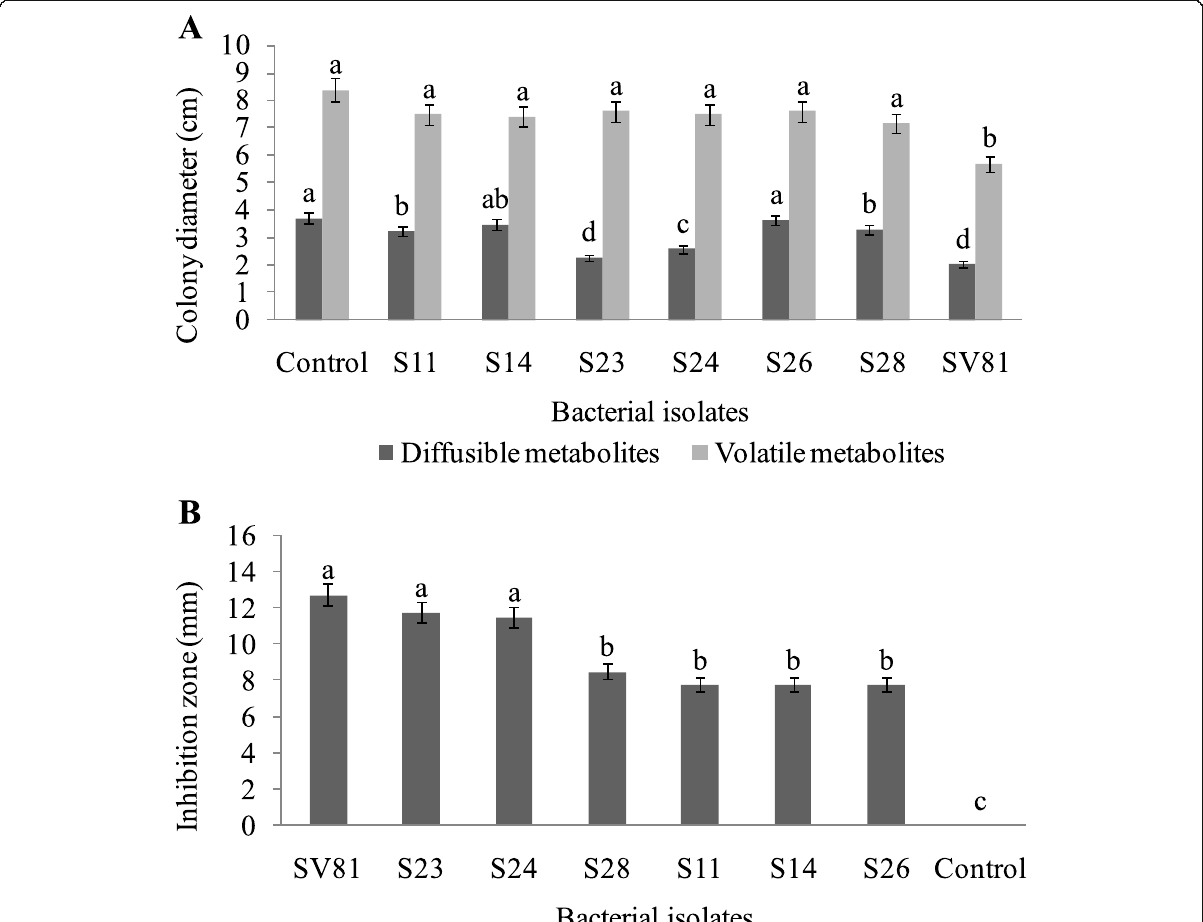
Fig. 5 Antifungal activity of the seven selected bacterial isolates, recovered from Solanum sodomaeum and Solanum bonariense , toward Fusarium oxysporum f. sp. lycopersici noted after 4 and 7 days of incubation at 25 °C. S11, Azotobacter chroococcum ; S14, Serratia marcescens ; S23, S24, S26 and S28, Stenotrophomonas maltophilia ; SV81: Bacillus sp. For each test, values with the same letter are not significantly different according to Student-Newman-Keuls test at P ≤